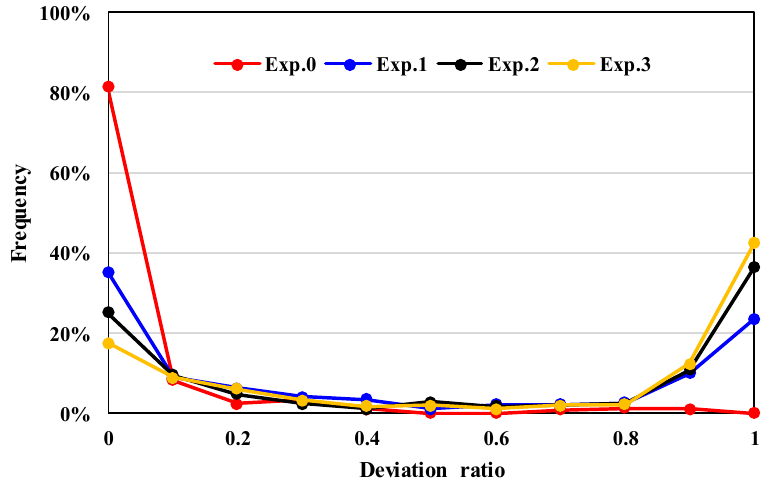
Figure 19. The distribution frequency of the deviation ratio in different stages.